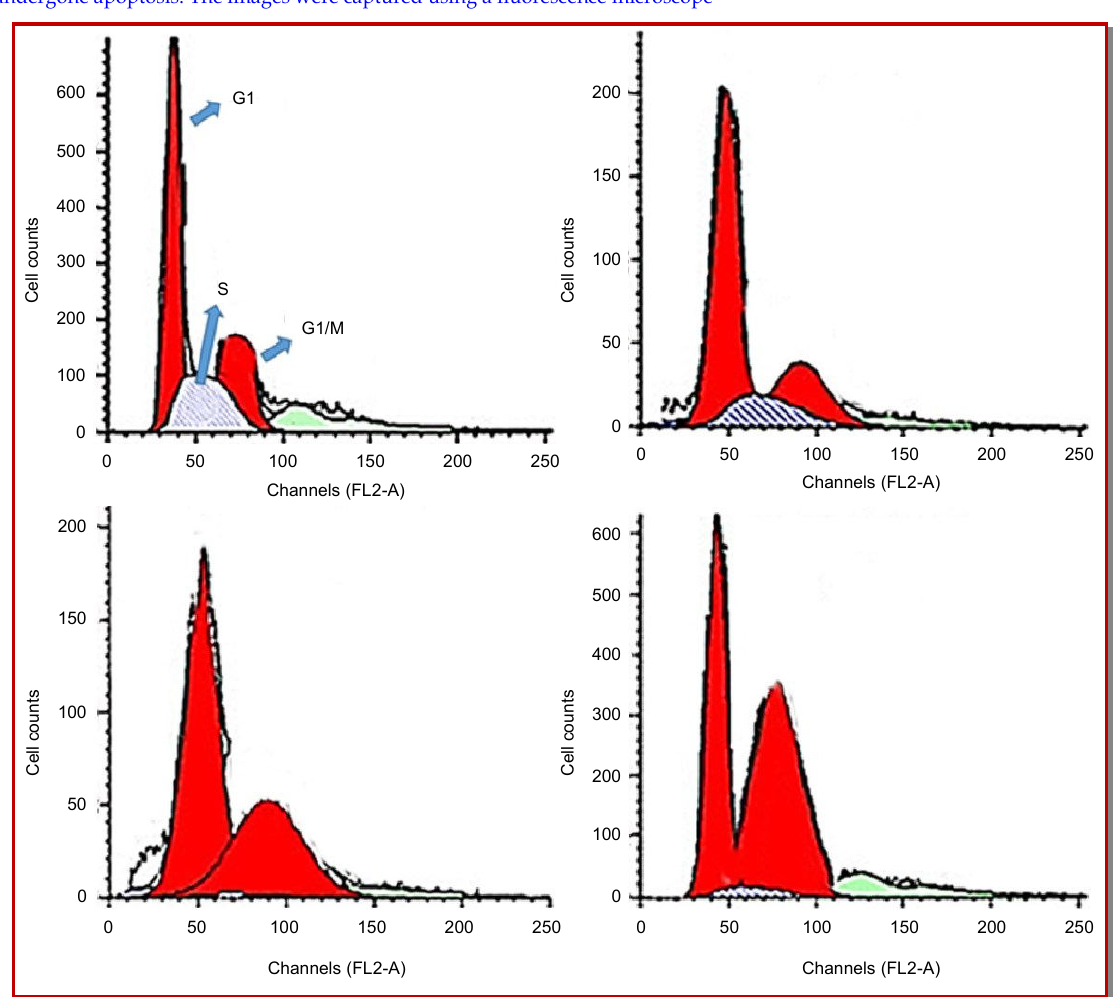
Figure 6: Corosolic acid induced G2/M cell cycle arrest in CaSki cervical cancer cells. Flow cytometry in combination with pro- pidium iodide was used to evaluate the effect of corosolic acid on cell cycle phase distribution in CaSki cells after the cells were treated without 0 µM (A), with 10, 50 and 100 µM of corosolic acid for 48